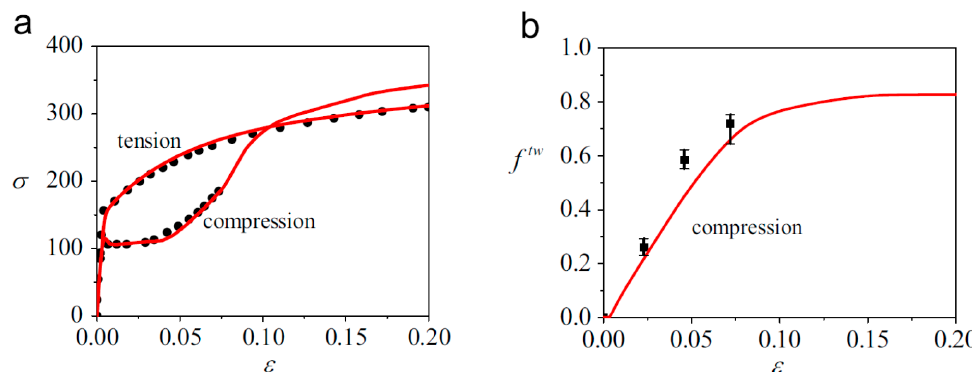
Figure 7. Extension twinning in Mg and its alloys. ( a ) The schematics of extension twin nucleation, propagation, and growth, ( b ) variation of slip resistance for extension twinning system 𝛼 at dif ‐ ferent stages of deformation twinning (After Wu et al. [105]).